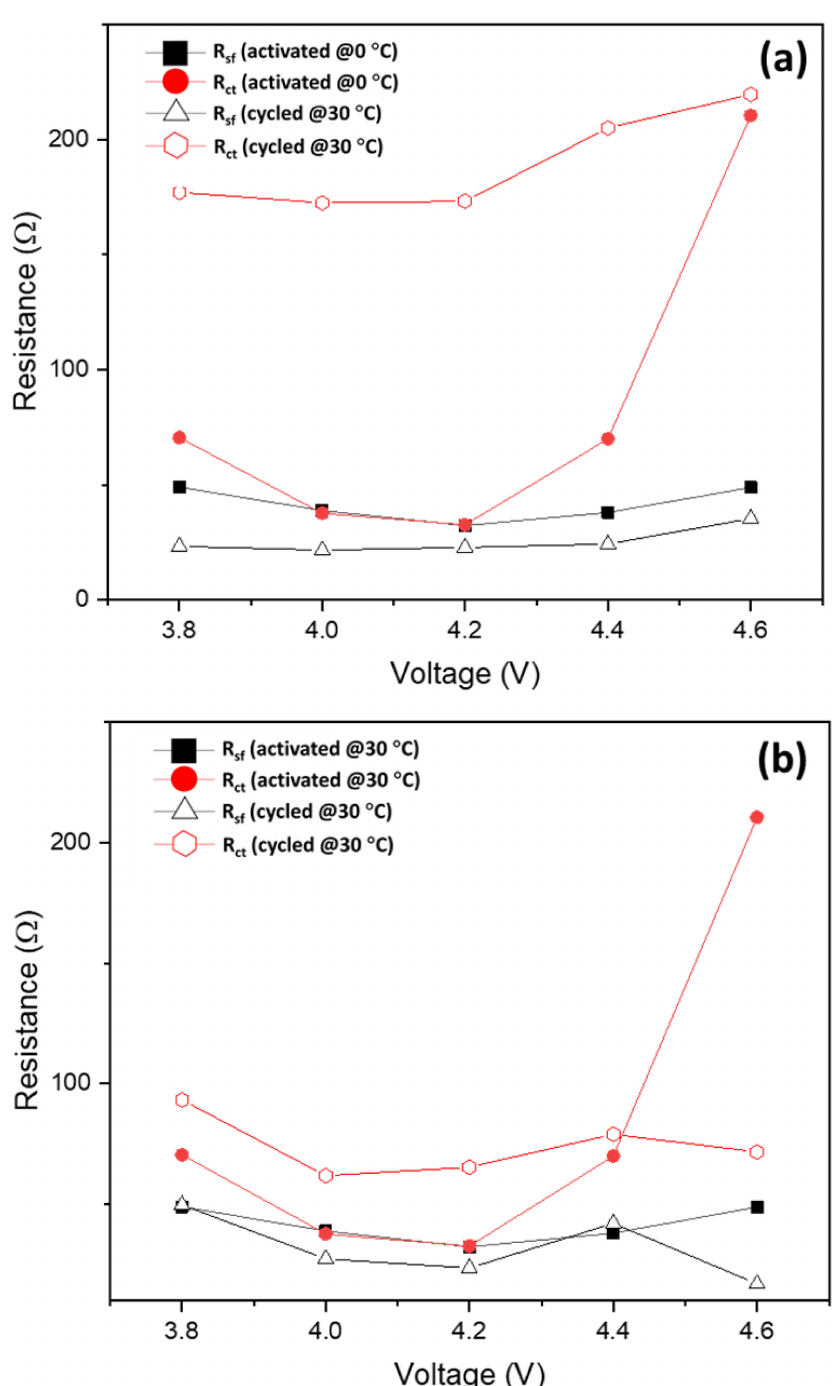
Figure 6. Surface film (R sf ) and charge-transfer (R ct ) resistances calculated from impedance spectra measured at 30 ◦ C from Li 2 MnO 3 electrodes initially activated at 0 ◦ C ( a ) and 30 ◦ C ( b ), respectively, as presented in Figure 3b, curves A and B . The corresponding points of impedance measurements are marked with green stars in Figure 3b. Typical impedance spectra (Nyquist plots) of these electrodes, measured at 30 ◦ C at 4.4 V upon charging, are displayed in Figure